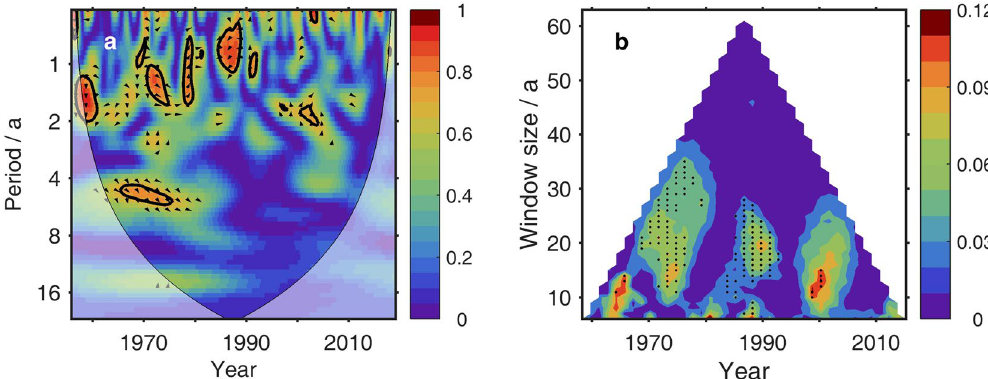
Figure 3. The original incorrect version of Figure 3.